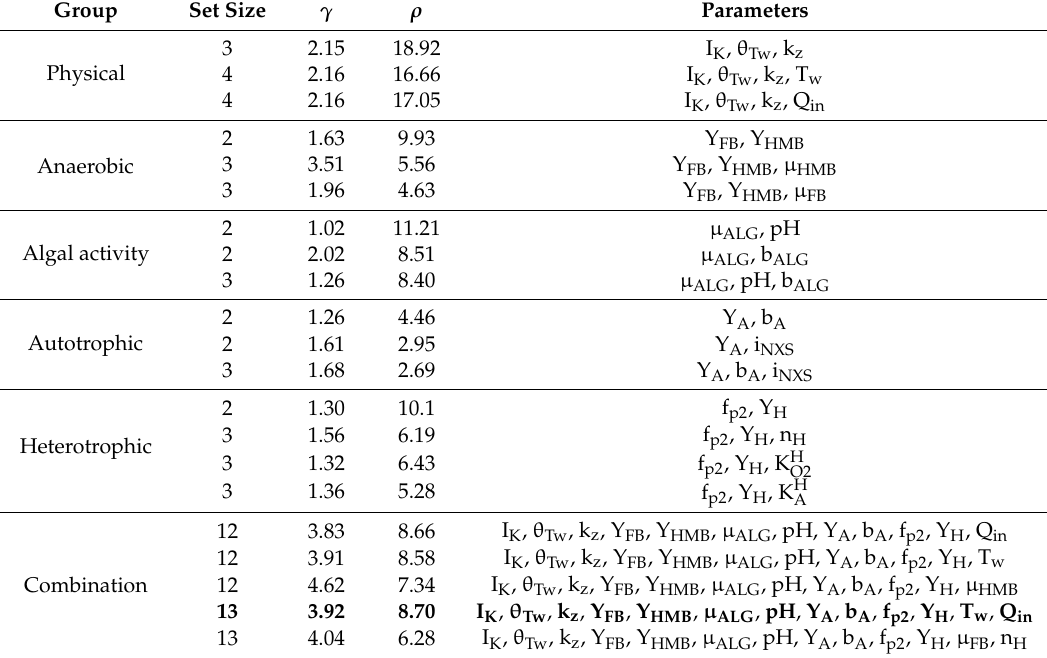
I K , θ Tw , k z , Y FB , Y HMB , µ ALG , pH, Y A , b A , f p2 , Y H , µ FB , n